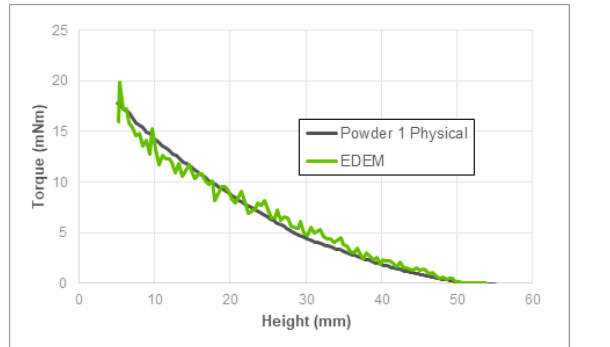
Table 1. Physical bulk density and matched simulated results.